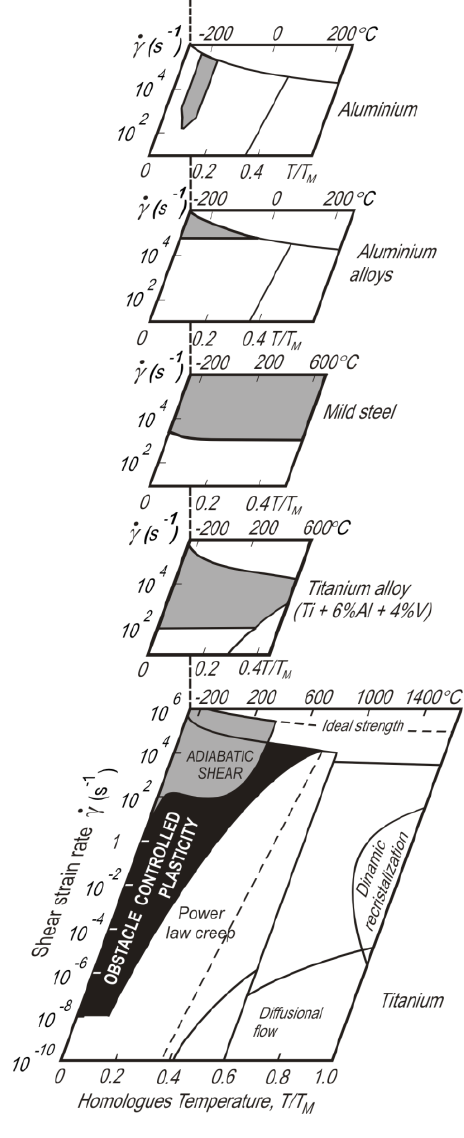
Figure 4. Strain rate/homologous temperature deformation maps. Based on [7, 8].